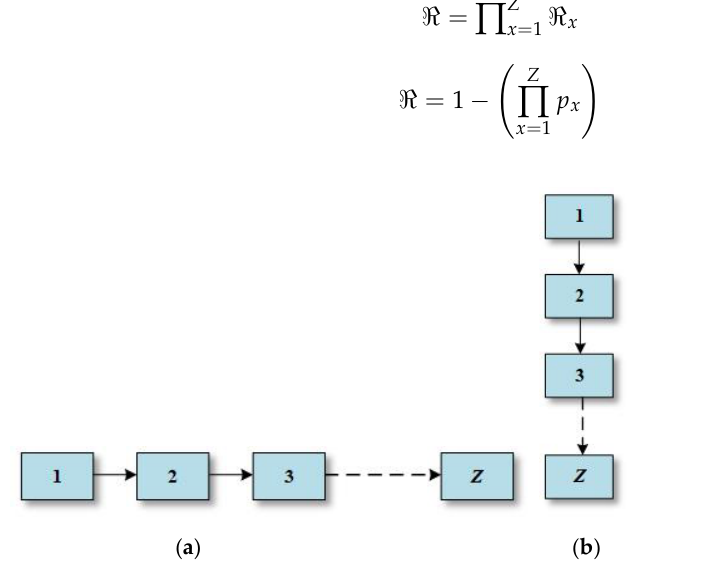
Figure 4. Illustration of components in SCN: ( a ) series configuration, ( b ) parallel configuration.